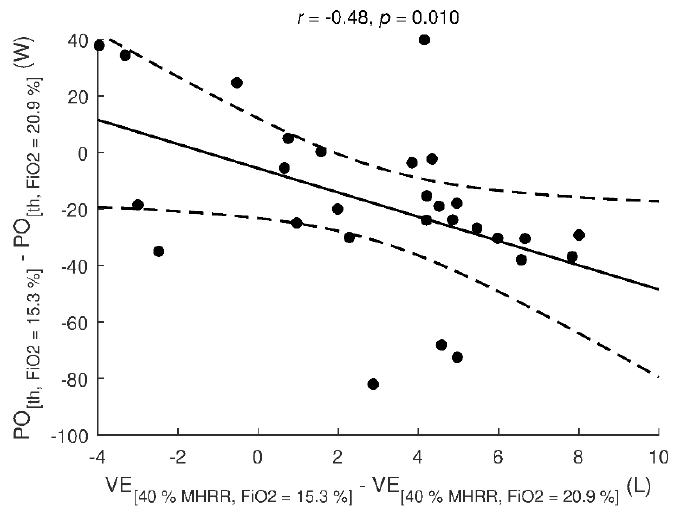
Figure 3. Association between changes in ventilation at step corresponding to 40% MHRR and changes in power output at vagal threshold. Changes were calculated as the value at hypoxia (FiO 2 = 15.3%) minus the value at normoxia (FiO 2 = 20.9%). Dashed lines denote 0.95-confidence interval. r : Pearson correlation coe ffi cient, p : significance of correlation, VE: minute ventilation, PO: power output, MHRR: maximal heart rate reserve, th: vagal